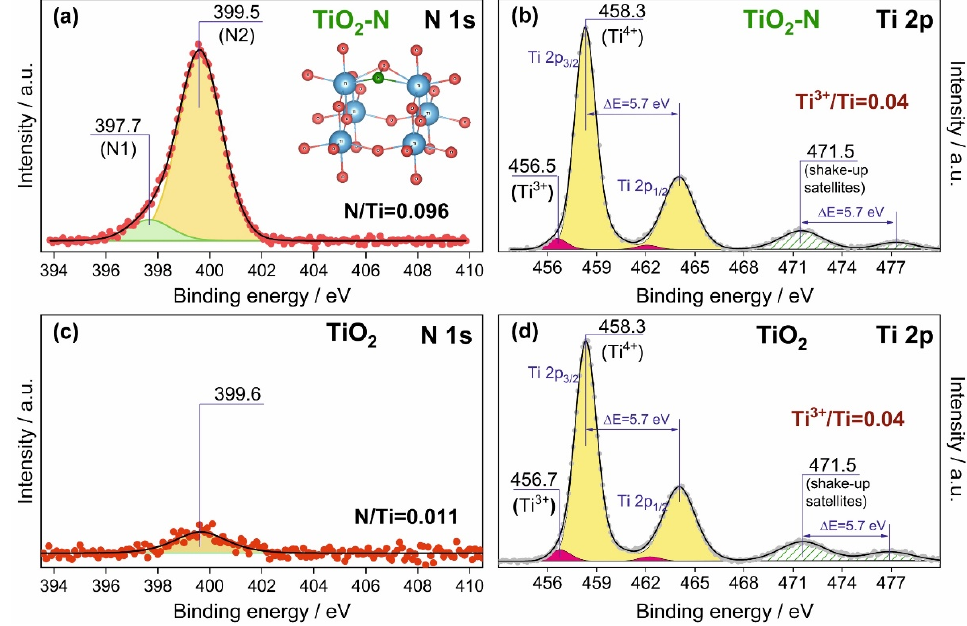
Figure 4. Photoelectron N 1s ( a , c ) and Ti 2p ( b , d ) spectral regions for TiO 2 -N and TiO 2 samples synthesized at 350 °C.